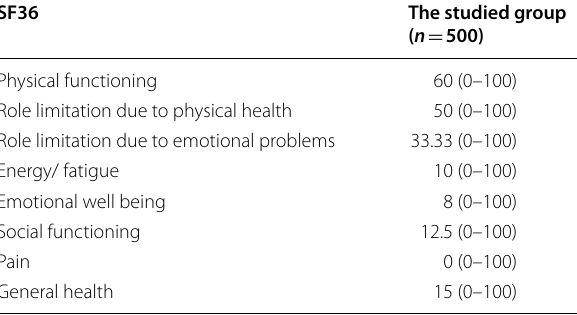
Table 3 Different domains of quality of life SF 36